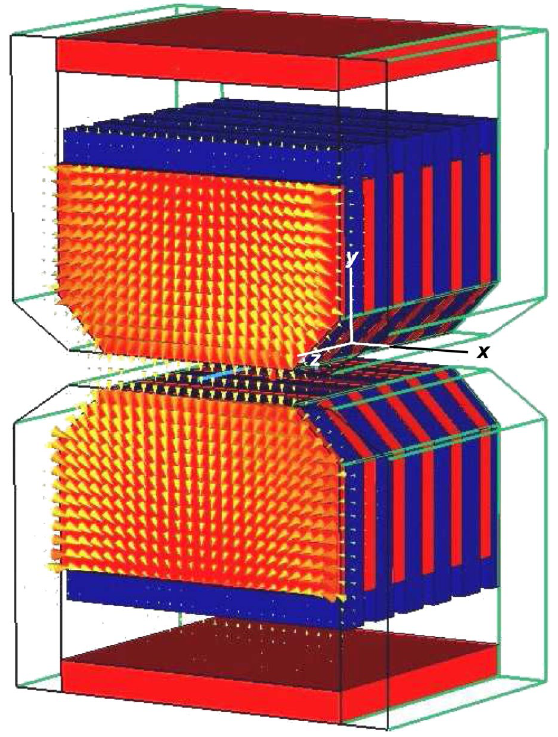
FIG. 2. (Color) Schematic view of the hybrid design of the miniature undulator, consisting of alternating plates of perma- nent magnets (blue), polarized parallel and antiparallel to the undulator axis z , and ferromagnetic material (red). In the front x - y plane arrows indicate the guiding of the magnetic field inside the ferromagnetic plates toward the undulator gap (simulation CST EM Studio). The transparent frames show the rail structure supporting the magnet blocks, also visible in the photograph in Fig.